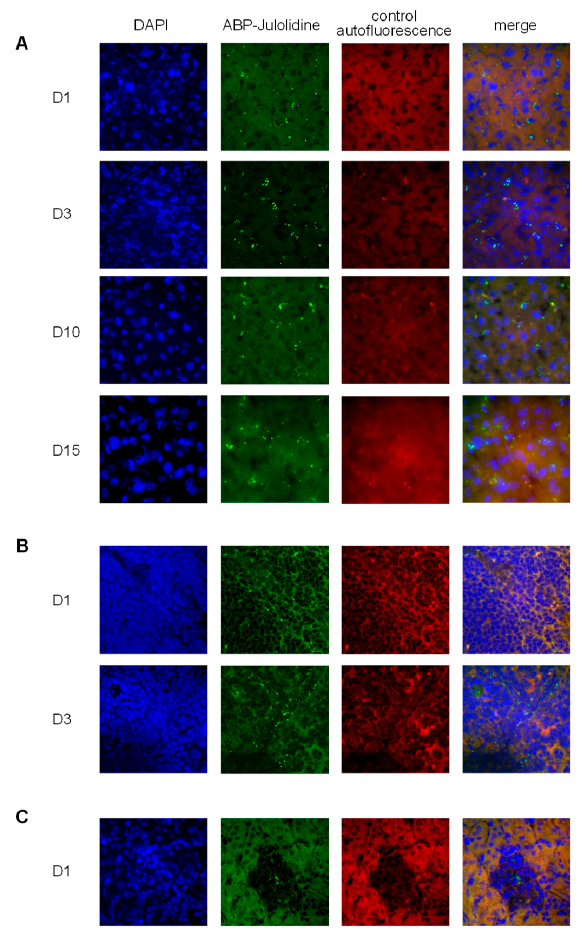
Figure 3. Fluorescence images at the sub-organ level after an IV injection of the ABP-Julolidine dendrimer (in green, second column), with DAPI (4',6-diamidino-2-phénylindole) nuclear staining (in blue, left column; merge on the right column), and the auto-fluorescence of the tissues as internal controls (in red, third column) for the liver at days one, three, 10 and 15 ( A ), the spleen at days one and three ( B ), and the kidney at day one ( C ). Images are representative of one mice out of